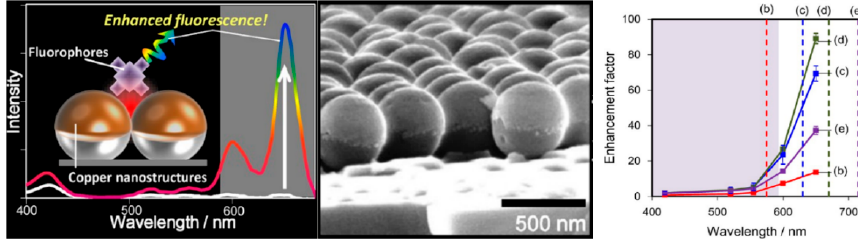
Figure 2. An ordered copper (Cu) nanosphere array along with the MEF enhancement factor (adapted with permission from reference [13]).